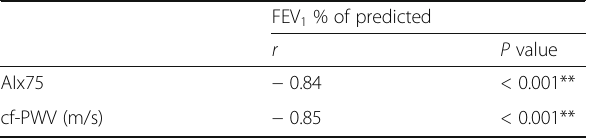
Table 3 Correlation between FEV 1 % of predicted, AIx75, and cf-PWV in studied COPD patients